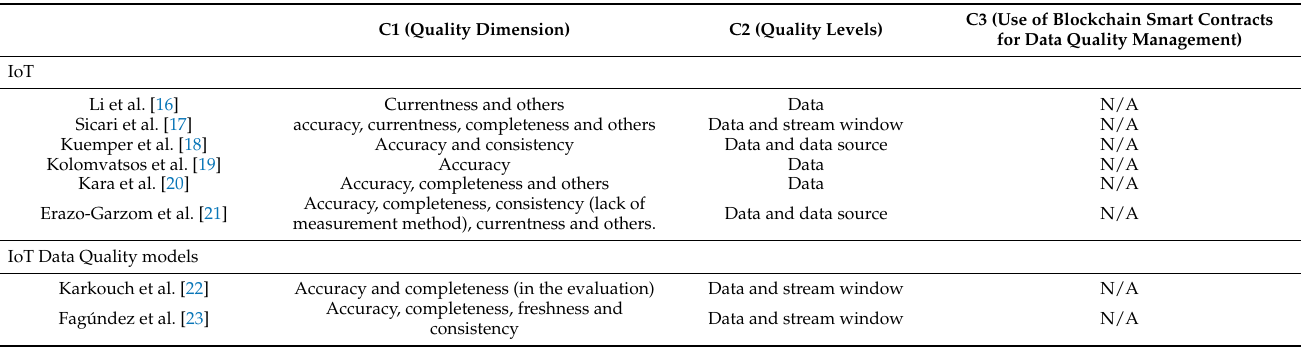
Table 1. Related works comparison